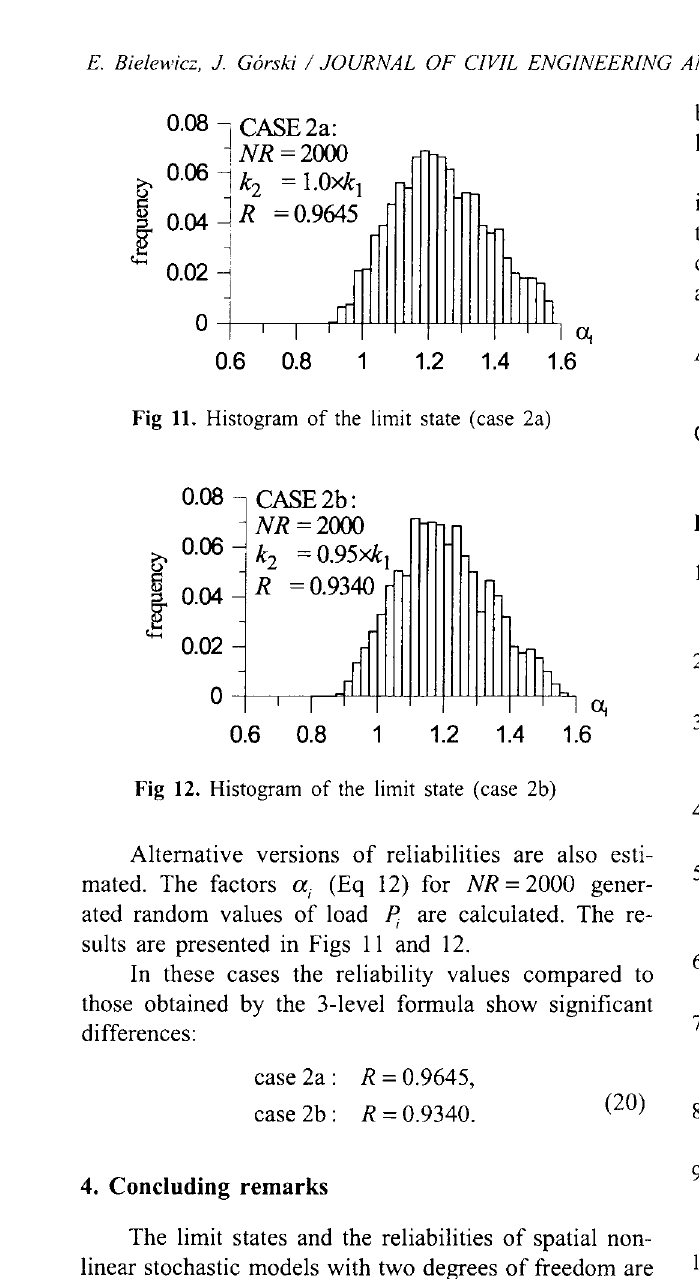
Fig 12. Histogram of the limit state (case 2b) Alternative versions of reliabilities are also esti mated. The factors a; (Eq 12) for NR = 2000 gener ated random values of load P; are calculated. The re sults are presented in Figs 11 and